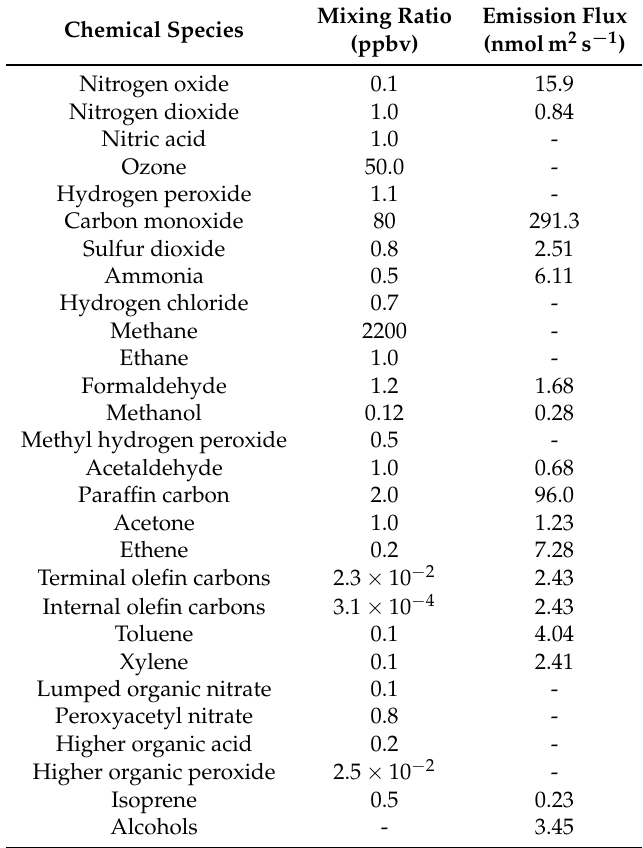
Table 4. Initial conditions and background mixing ratios (second column) and twelve-hour average emission (third column) prescribed in simulations of gaseous species for the ten environmental